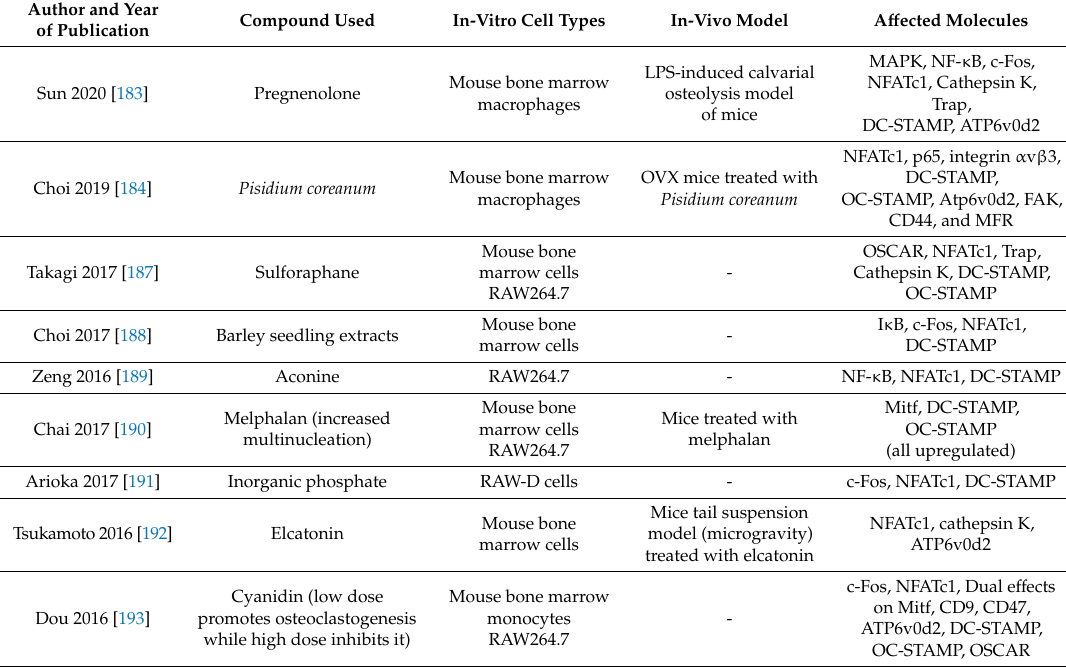
Table 1. Recent studies of various compounds targeting osteoclast